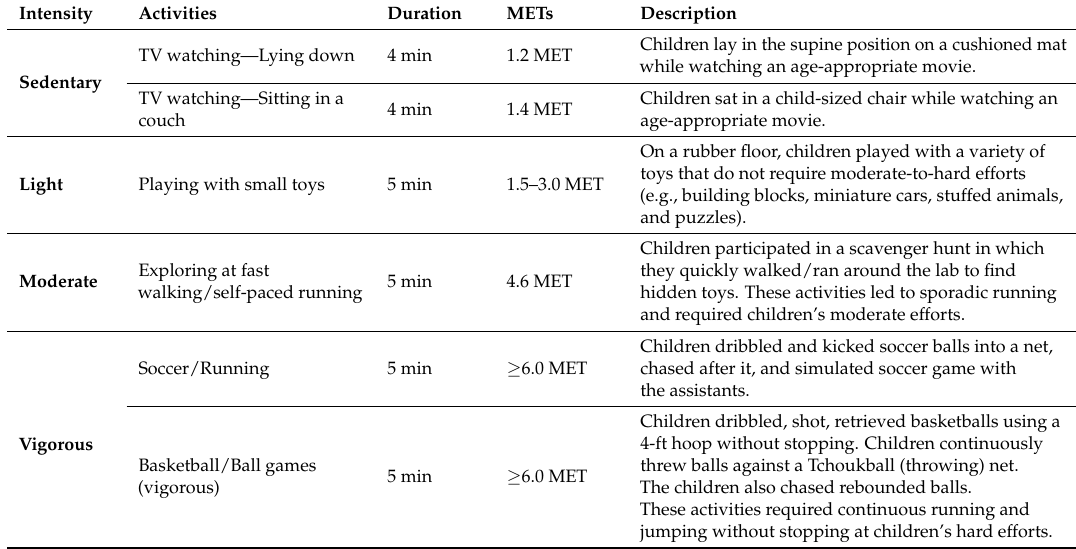
Table 1. Description of performed activities by